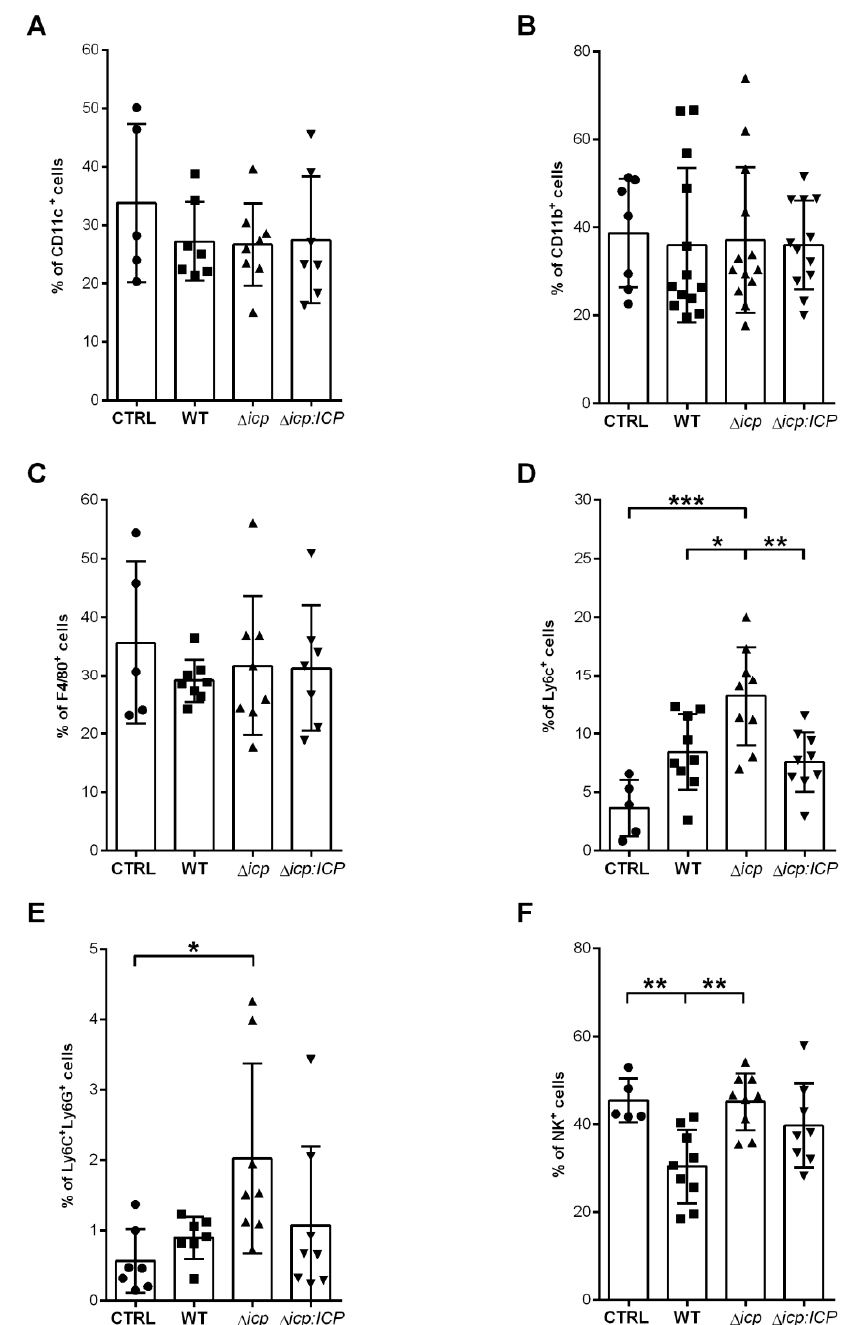
Figure 8. T. b. rhodesiense ∆ icp induces increased recruitment of monocytes to the inoculation site during early infection of C57BL/6 mice. C57BL/6 mice were infected with BSF parasites of T. b. rhodesiense WT, ∆ icp , and ∆ icp : ICP (1 × 10 5 parasites per animal). On the second day post-infection, mice were euthanized, and the peritoneal cavity was washed with RPMI in order to collect the peritoneal cells. The peritoneal cells were submitted to flow cytometry to assess expression of ( A ) CD11c, ( B ) CD11b, and ( C ) F4/80 within the total cell population, and ( D ) Ly6C + Ly6G − cells and ( E ) Ly6C + Ly6G + within the CD11b + population. ( F ) Expression of NK1.1 within the total cell population. CTRL represents the non-infected control that was injected with RPMI medium. Graphs show individual points representing each mouse sample and the mean ± SD of two or three combined experiments (n ≥ 3 per group per experiment). Asterisks indicate statistical significance at p < 0.05 (*), p < 0.01 (**), and p < 0.001 (***) as assessed by one-way ANOVA with Tukey’s post hoc